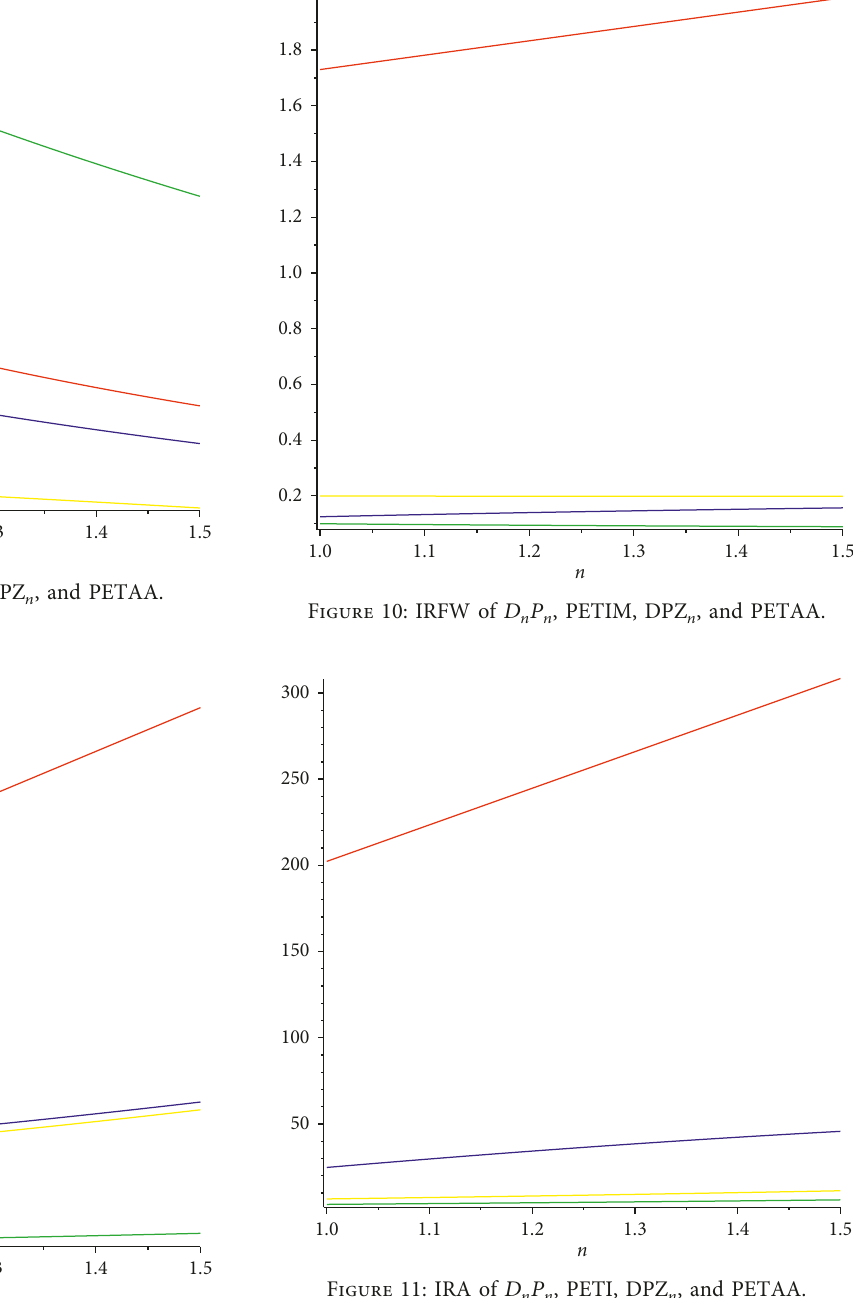
Figure 9: IRF of D